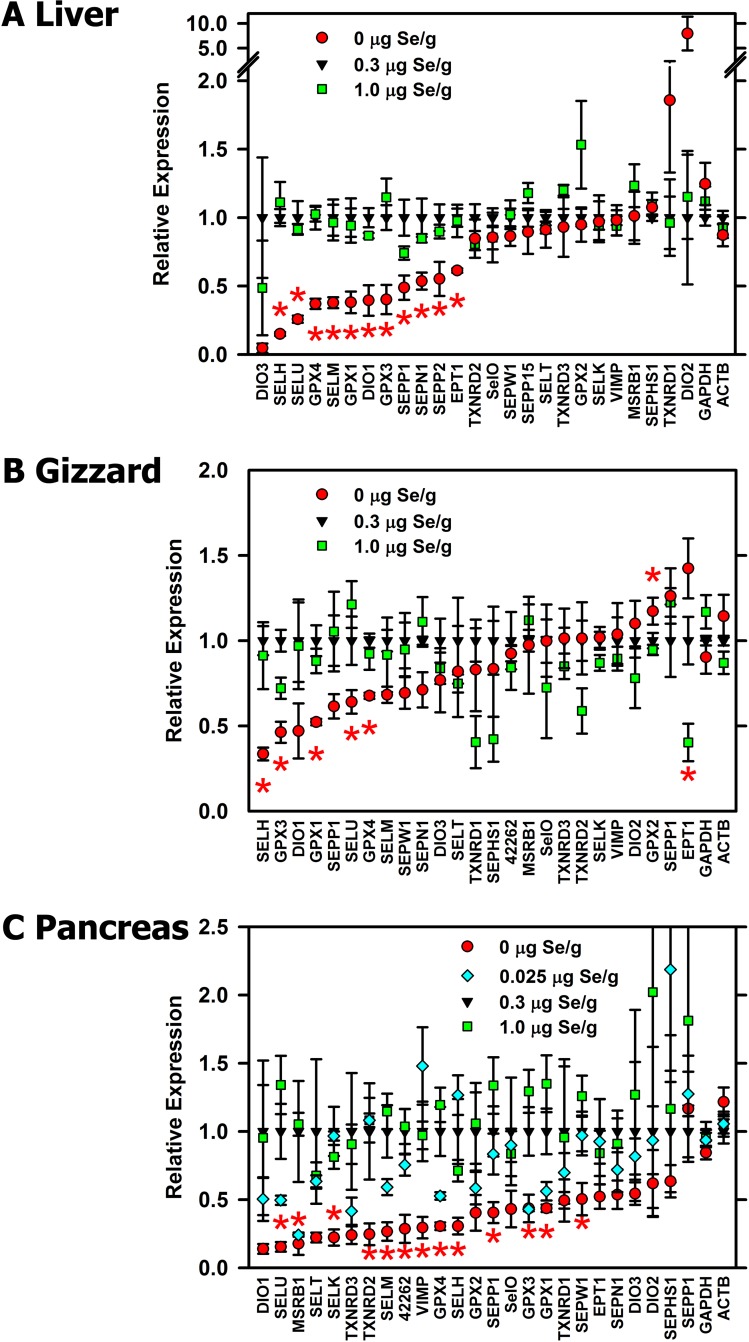
Effect of Se status on relative expression of selenoprotein transcripts in chick liver (A), gizzard (B) and pancreas (C). Liver and gizzard RNA was from chicks supplemented with 0, 0.3, or 1.0 μg Se/g diet. Pancreas RNA was from chicks supplemented with 0, 0.025, 0.3, or 1.0 μg Se/g diet. Relative transcript expression for each gene was determined by qPCR and expressed relative to the level in Se-adequate (0.3 μg Se/g diet) Bars show the mean±SEM (n = 4). Asterisks indicated significant effects of dietary treatment (P<0.05).